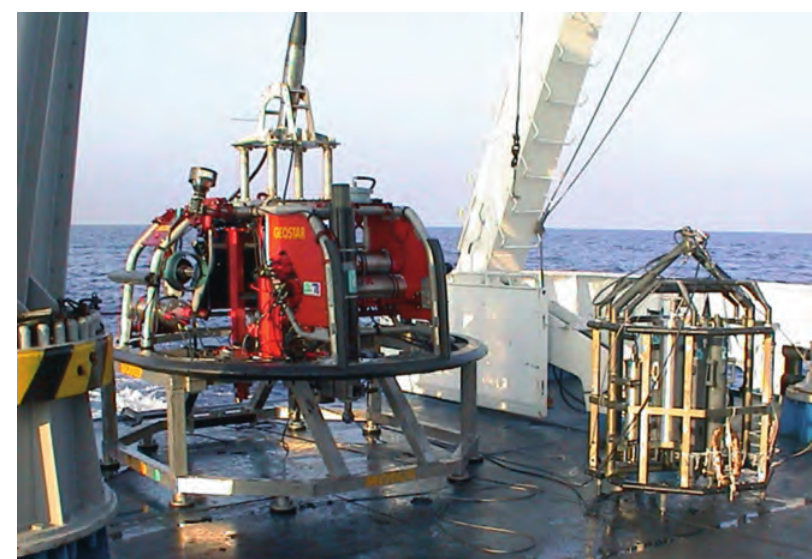
Fig. 3. MODUS with SCISKID ( left ) and SCIPACK ( right ) onboard R/V Urania.